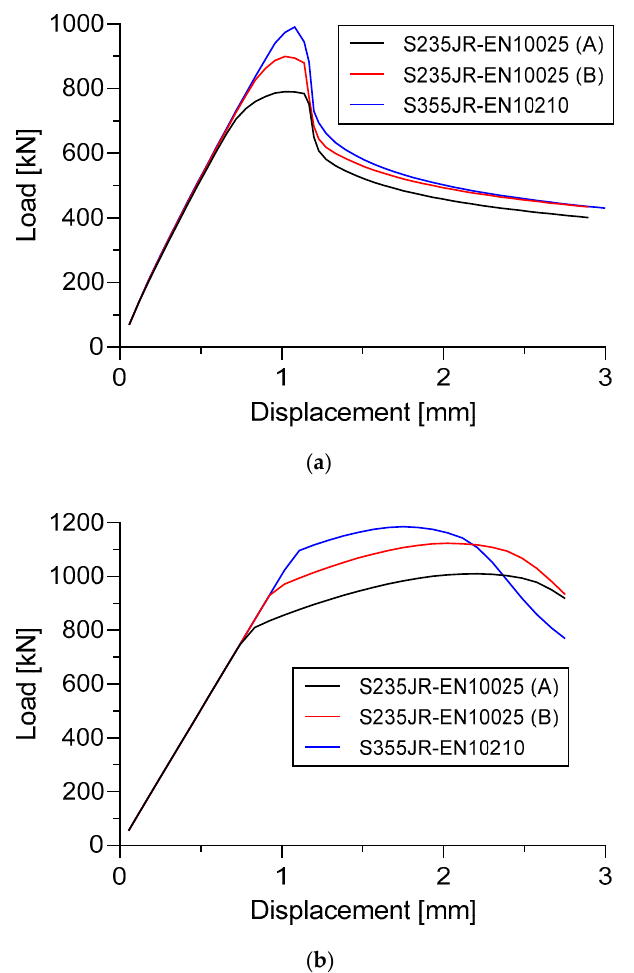
Figure 27. Effect of materials change to the load versus displacement curve. ( a ) Specimen A; ( b ) Specimen